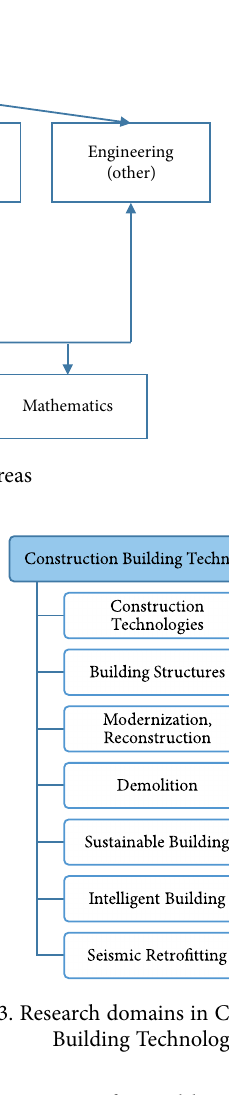
Table 1. Description of MCDM methods by authors